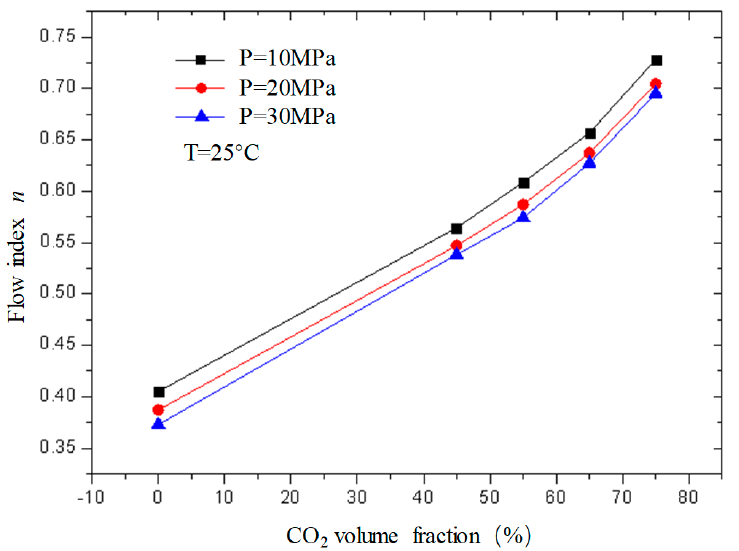
Figure 11. Variation curve of flow index n with CO 2 volume fraction under different pressures (unfoamed).